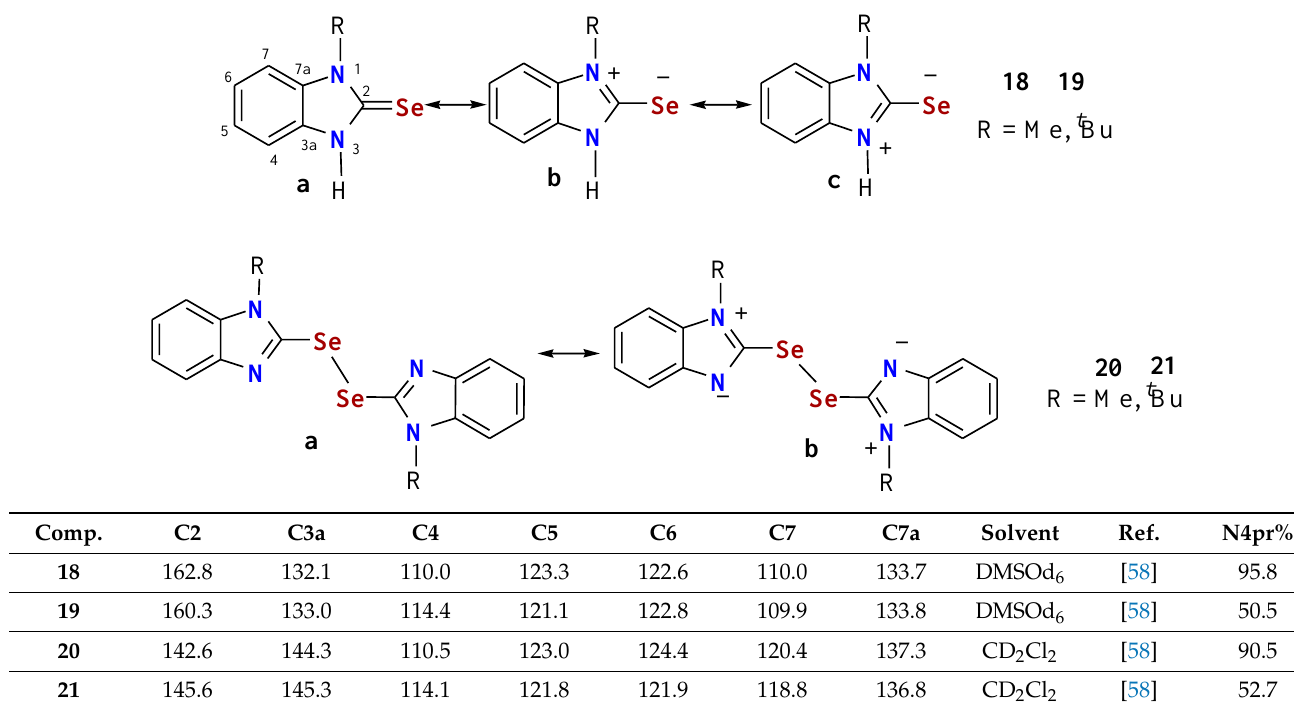
Table 7. Alkylbenzimidazolidine-2-selenones 18 and 19 and their diselenide derivatives 20 and 21 .